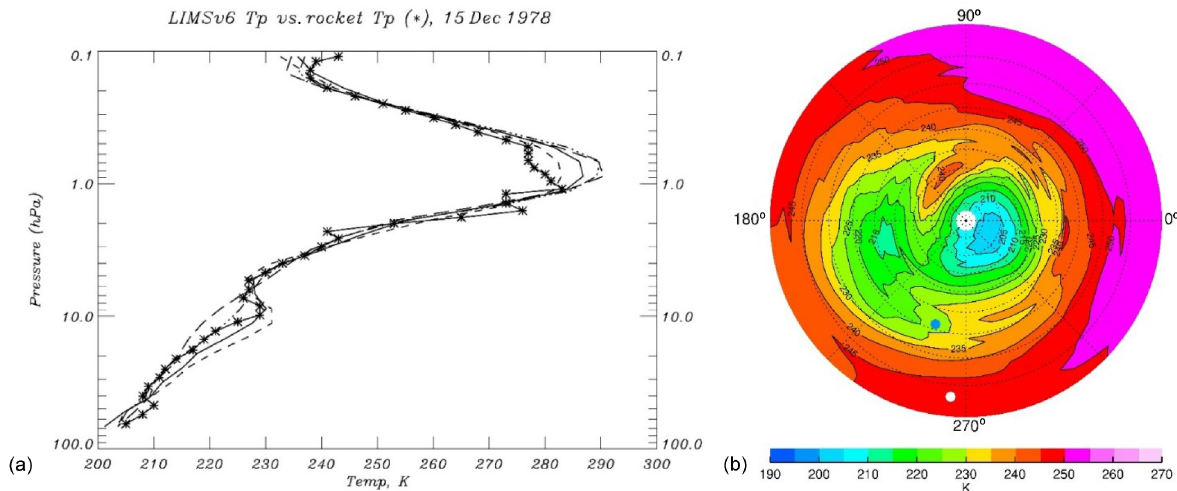
Figure 5. (a) Profiles of V6 temperature compared with datasonde values (*) on 15 December. The four V6 profiles are separated as in Fig. 4, where the short-dashed curve is for 29.2 ◦ and the long-dashed curve is for 37.2 ◦ . (b) NH V6 temperature distribution at 4.6hPa; CI is 5K; satellite location is the white dot, and White Sands is the blue